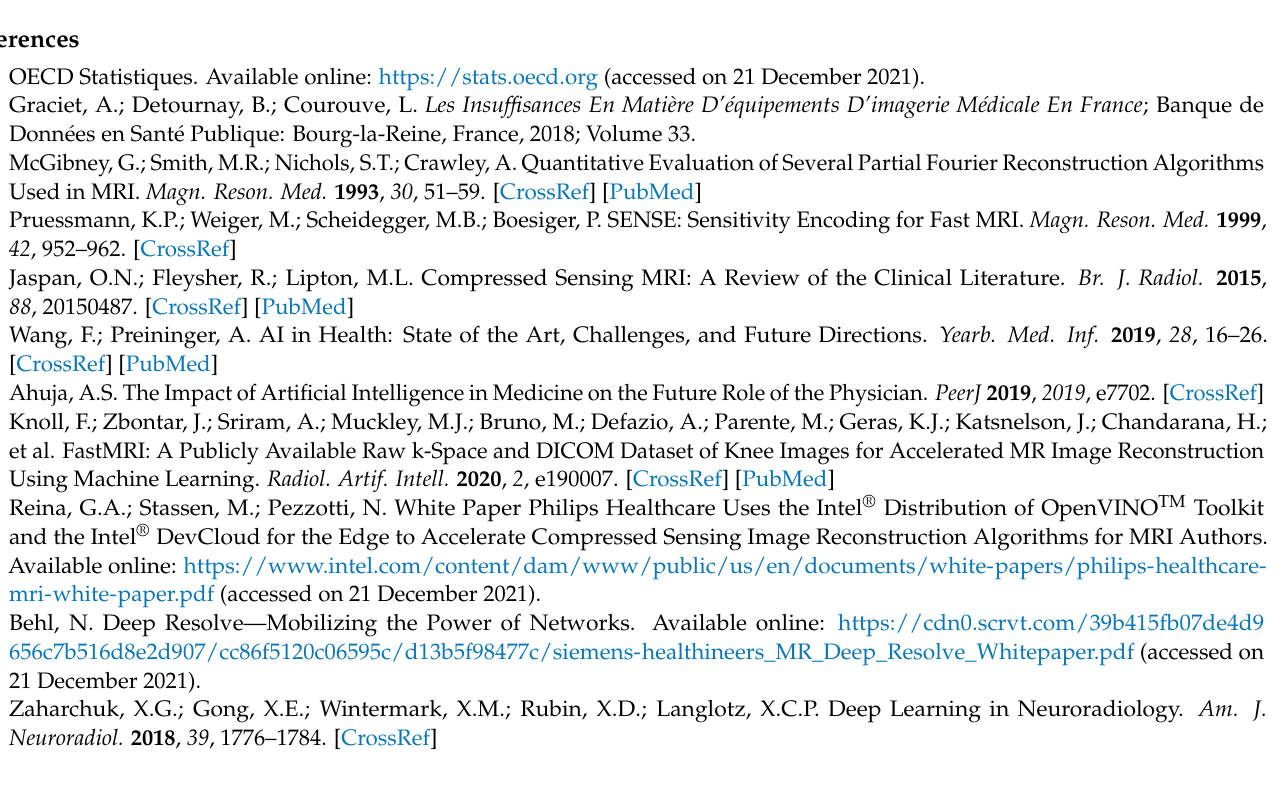
Figure S2: Bland–Altman plots showing the difference between predictive values obtained from radiomic model. Figure S3: Quantitative analyzes of the efficiency of the denoising DL model with the comparison with fast image concerning. Figure S4: ESPCNN and U-NET DL models compari- son. Figure S5: Example of motion artefact corrected by the U-NET DL model. Figure S6: Pearson correlation of kurtosis, skweness, glcm MCC values between reference and fast and DL images. Table S1: Paired t -test of DL resampling impact on radiomic features. Table S2: Comparison of ICC for different radiomic models features between reference, fast image and DL